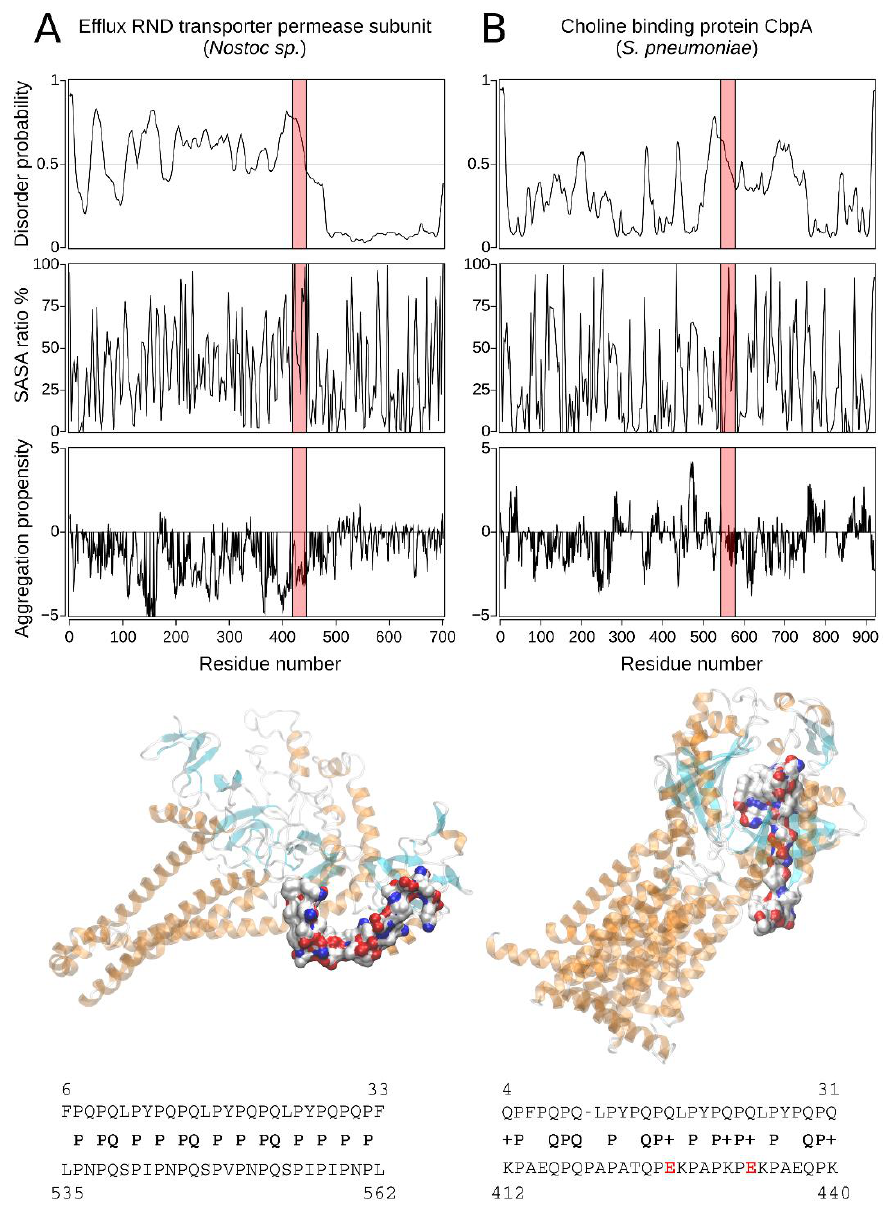
Figure 4. Sequence and structural characterization of target proteins found by BLASTp search of the 33-mer peptide. For both target proteins from Nostoc sp. ( A ) and Streptococcus pneumoniae R6 ( B ) the region sharing high sequence similarity with the 33-mer sequence is shown in a red box. The disorder prediction (top panel) of the best hits was calculated by the PrDOS server setting a 5% threshold (false positive rate, gray horizontal line). The percentage of solvent-accessible surface area (SASA) was calculated after an energy minimization of the tridimensional models (middle panel). The structure-based aggregation propensity (lower panel) was calculated using AGGRESCAN 3D, where positive values indicate an aggregation-prone region (horizontal line). The tridimensional structure of the target proteins was modeled using the PHYRE2 server. The regions sharing high sequence similarity with the 33-mer sequence are shown in surface representation. In addition, the sequence alignments between the 33-mer sequence and the high similarity region of the target proteins are shown at the bottom. Relevant amino acid exchanges, such as Gln to Glu, are marked in red in the alignment of panel ( B ).